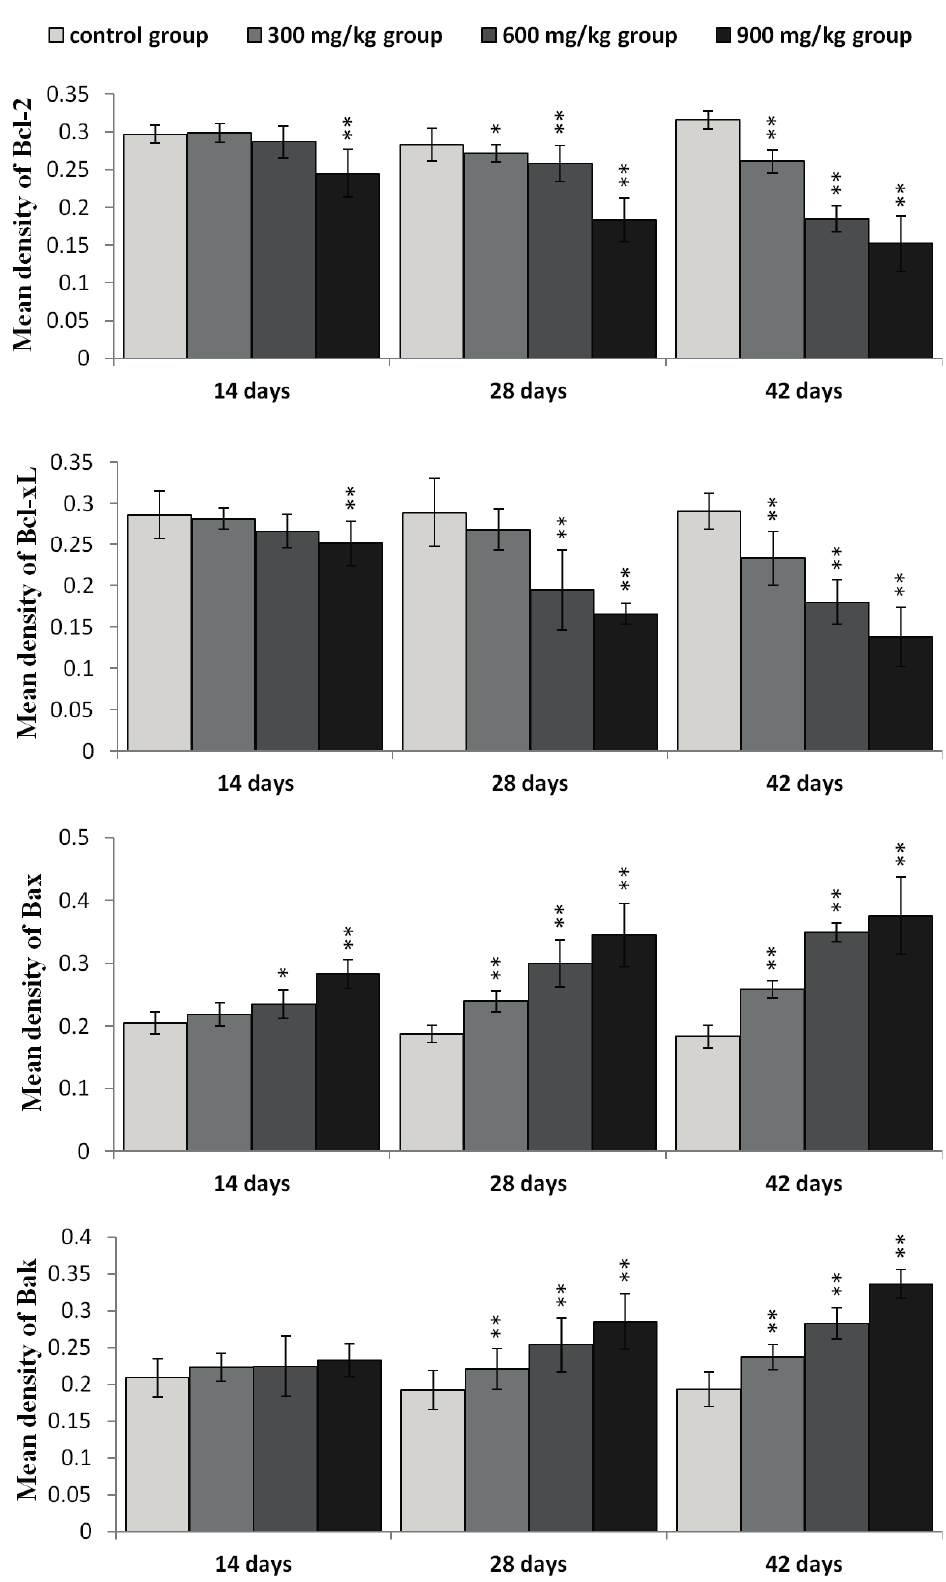
Figure 10. The protein expression levels of Bcl-2, Bcl-xL, Bax and Bak in the kidney. Data are presented with the mean ± standard deviation ( n = 5 × 5); * p < 0.05, compared with the control group; ** p < 0.01, compared with the control